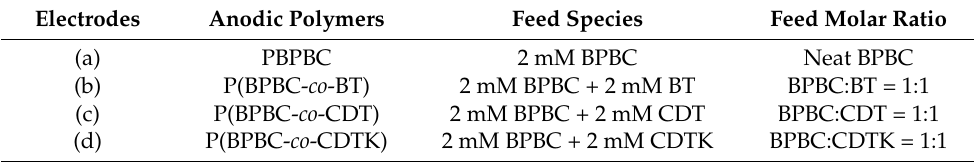
Table 1. Feed species of anodic polymers.